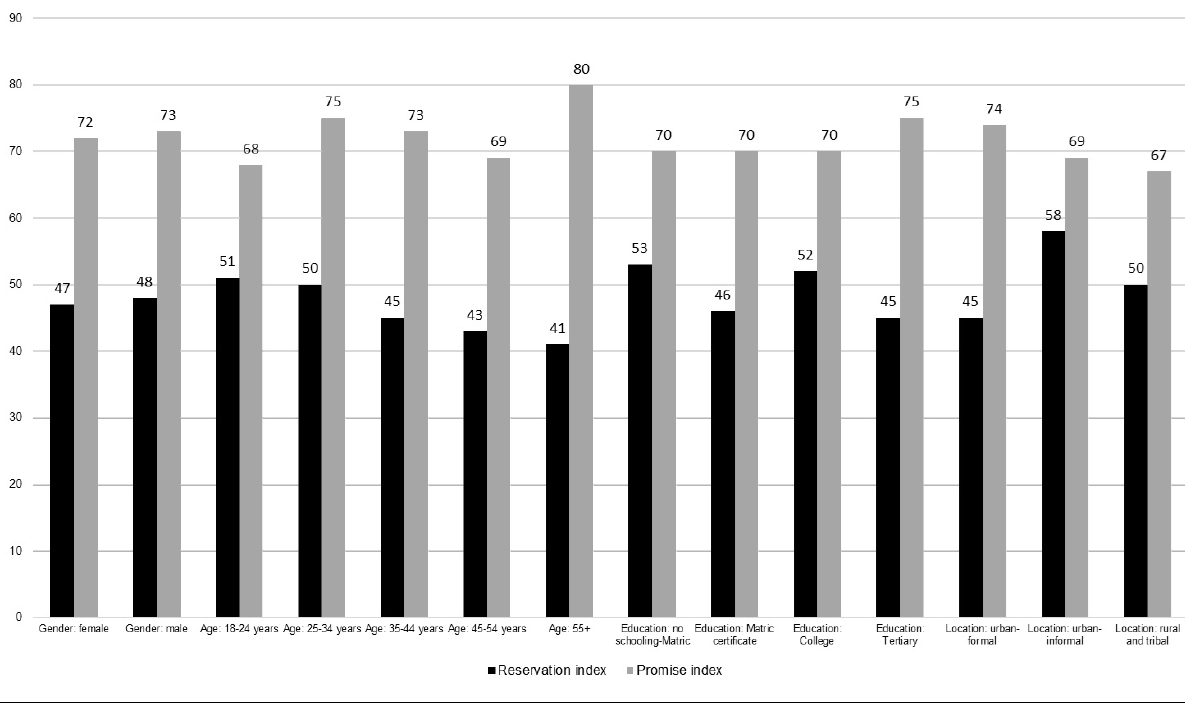
Figure 2: Promises of and reservations about science and technology by gender, age categories, educational level, and geographical